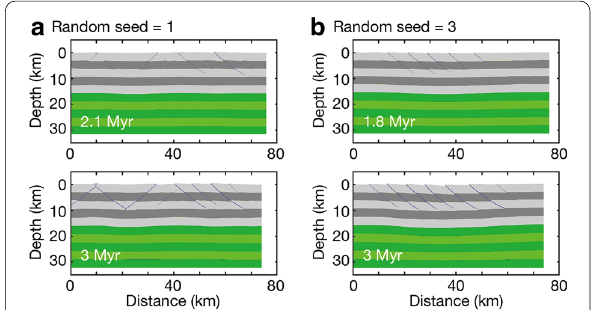
Fig. 7 Results for the numerical simulations without any preexisting fault zone. The newly formed faults (markers with a cumulative strain larger than 1) are illustrated in dark blue. a Case with the random seed number 1. b Case with the random seed number =